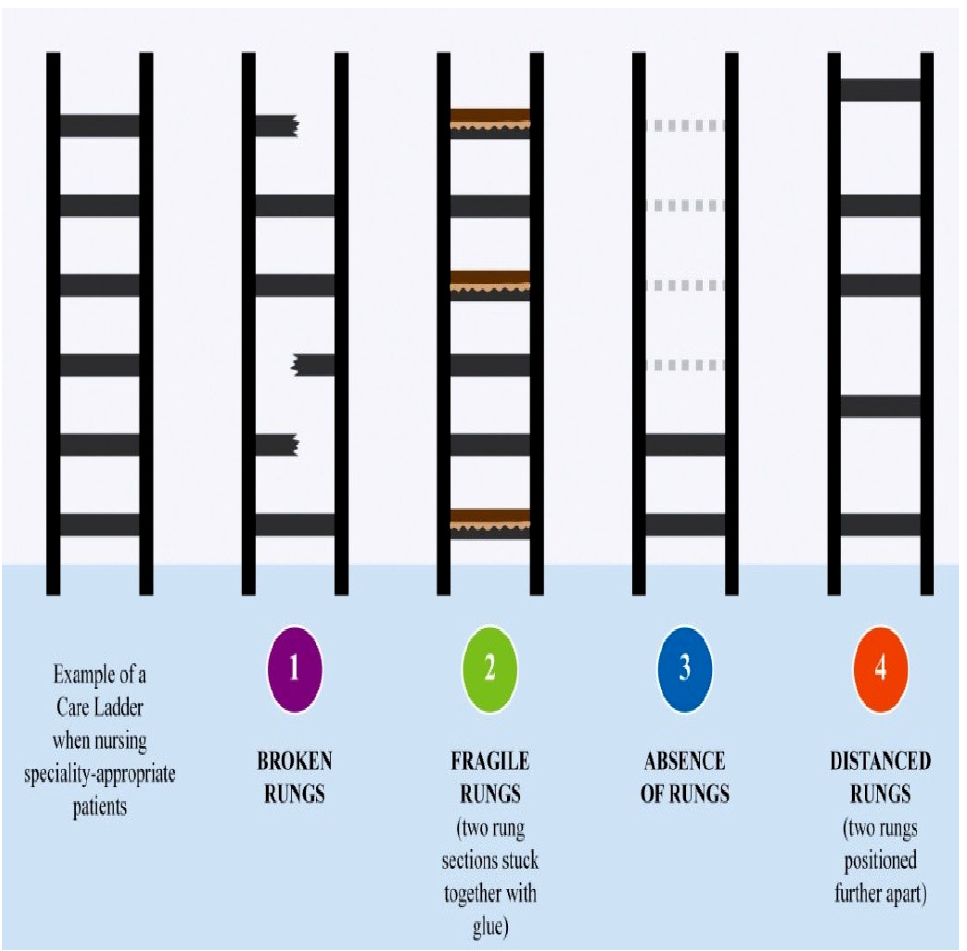
Figure 4. Four potential rung disruptions as an outcome of nursing outlier patients compared with nursing specialty-appropriate patients.